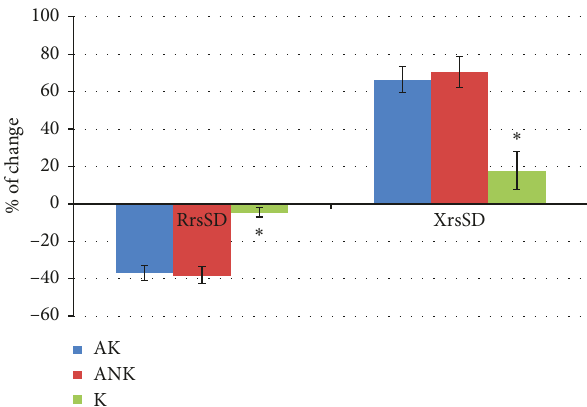
Figure 2: Percentage of changes in the Rrs and Xrs after salbutamol in comparison to baseline in the studied groups. XrsSD: average reactance with standard deviation; RrsSD: average resistance with standard deviation; significant differences (ANOVA test) for p 0 . 05; AK: patients with controlled asthma; ANK: patients with ∗ uncontrolled asthma; K: control group. <